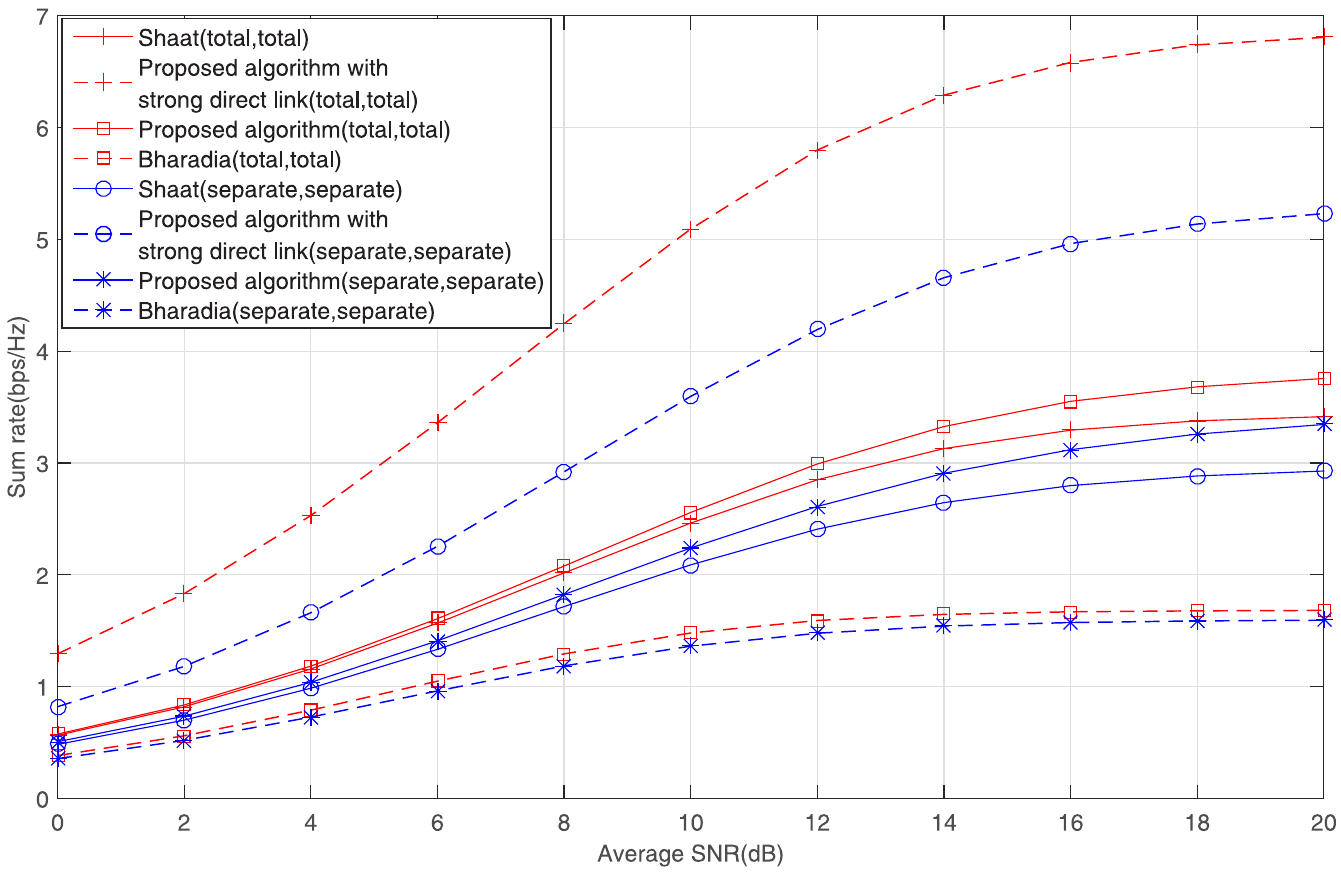
Fig 8. A comparison of our algorithm, Shaat’s and Bharadia’s